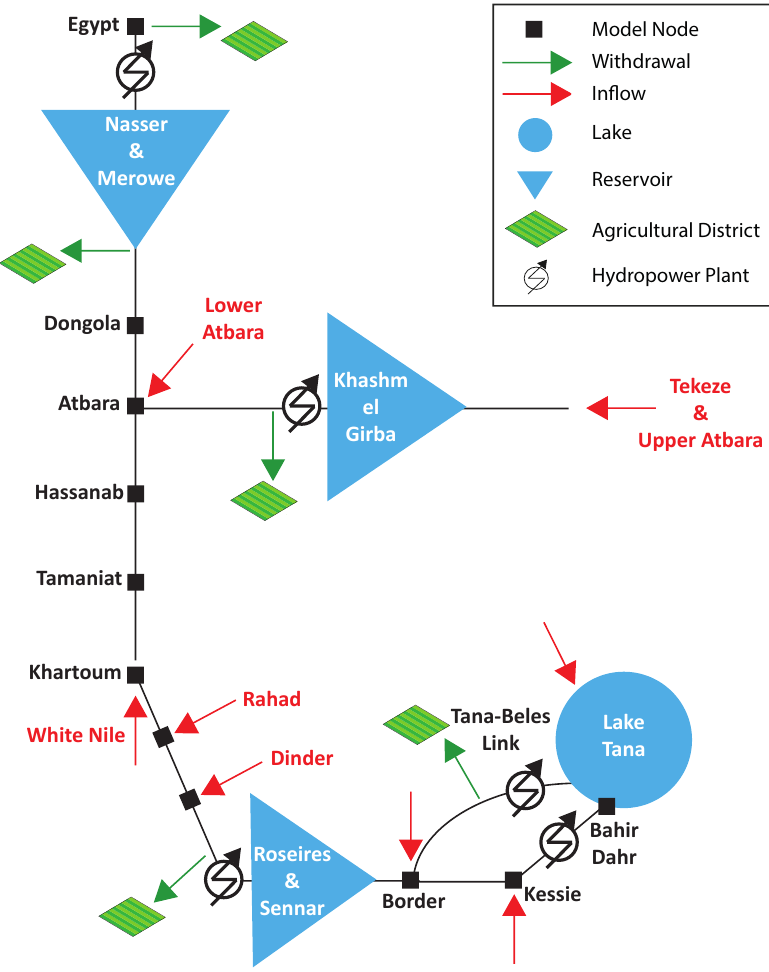
Figure 9. Schematic representation of the Lower Nile River system. Figure modified from